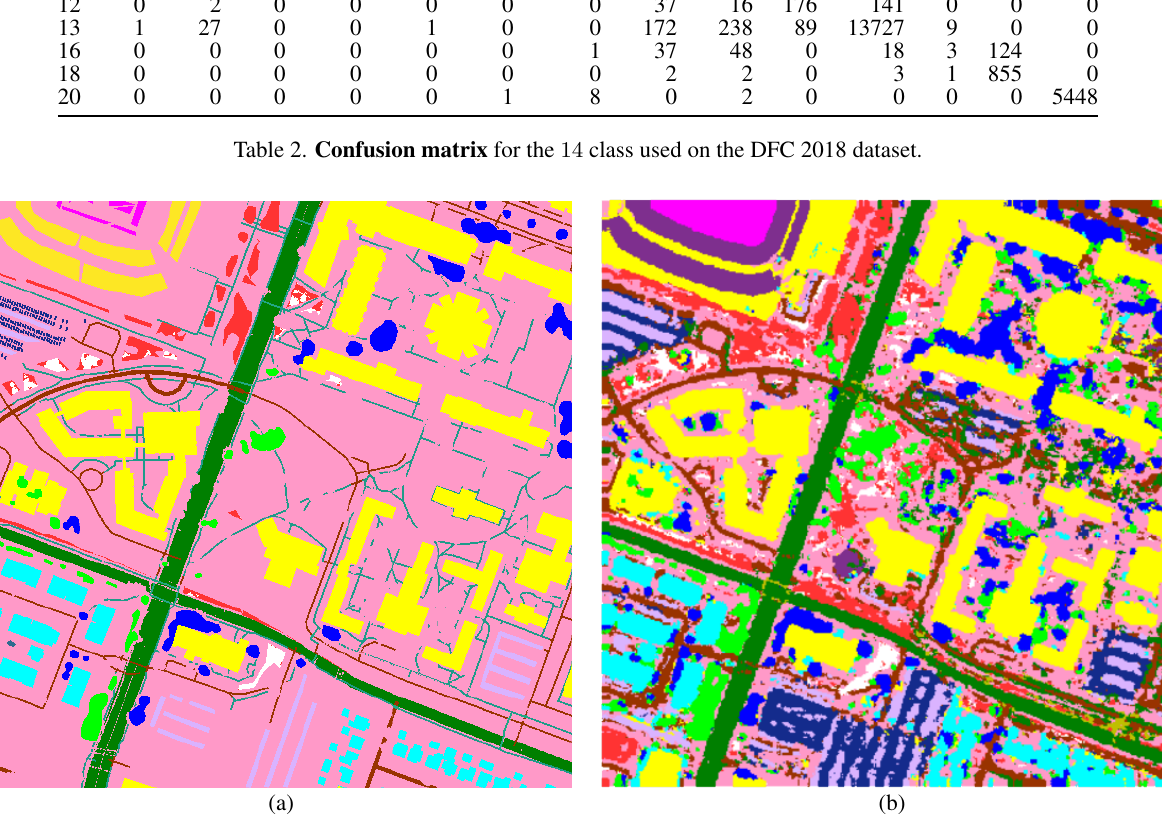
Figure 6. Classification results on the DFC 2018 dataset. (a) ground truth and (b) : our